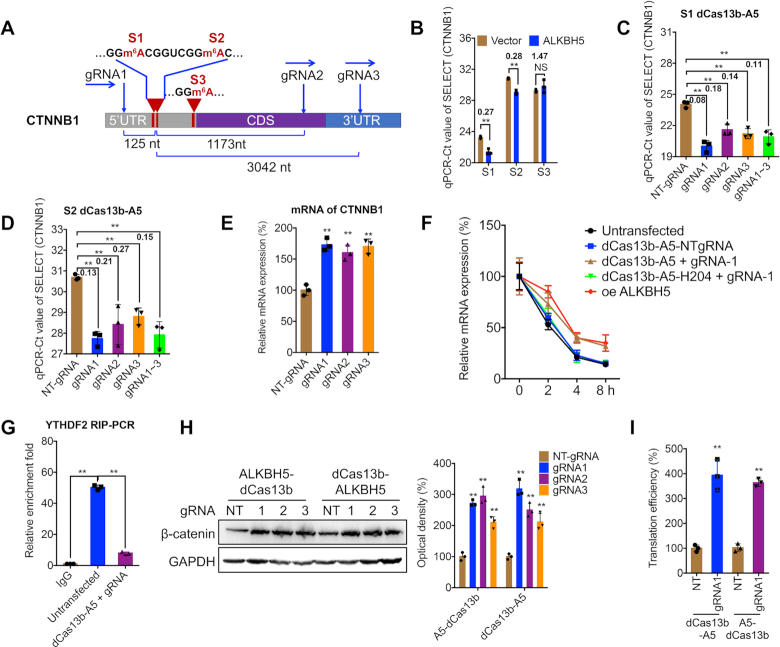
dm6ACRISPR induces demethylation of multiple m6A sites of 5′UTR. (A) Schematic representation of positions of m6A sites within CTNNB1 mRNA and regions targeted by three gRNAs; (B) Threshold cycle (Ct) of qPCR showing SELECT results for detecting m6A in three potential m6A sites of CTNNB1 in HEK293T cells transfected with vector control (pcDNA3.1) or pcDNA/ALKBH5, with fold changes listed; (C, D) Threshold cycle (Ct) of qPCR showing SELECT results for detecting the m6A S1 (C) or S2 (D) site in CTNNB1 in HEK293T cells transfected with dCas13b-ALKBH5 combined with NT-gRNA or gRNA1/2/3, respectively, for 24 h, with fold changes listed; (E) mRNA levels of CTNNB1 in HEK293T cells transfected with dCas13b-ALKBH5 combined with NT-gRNA or gRNA1/2/3, respectively, for 24 h; (F) HEK293T cells were pre-transfected as indicated for 24 h and then further treated with Act-D for the indicated time periods. The mRNA levels of CTNNB1 were measured by qRT-PCR. oe, overexpression; (G) HEK293T cells were pre-transfected as indicated for 24 h. Binding between YTHDF2 and CTNNB1 mRNA was checked by RIP-qPCR using YTHDF2 antibody; (H) Protein expression of β-catenin in HEK293T cells transfected with dCas13b-ALKBH5 combined with NT-gRNA (NT) or gRNA1/2/3, respectively, for 24 h was checked by western blot analysis (left) and quantitatively analyzed (right); (I) cells were transfected with pGL-5′UTR, NT-gRNA (NT) or gRNA1, and dCas13b-ALKBH5 or ALKBH5-dCas13b and pRL-TK reporter for 24 h. Translation efficiency is defined as the quotient of reporter protein production (F-luc/R-luc) divided by mRNA abundance (31). Data are presented as mean ± SD from three independent experiments. ** P < 0.01 by Student's t test (B and I) or one-way ANOVA (C, D, E, F, G and H).